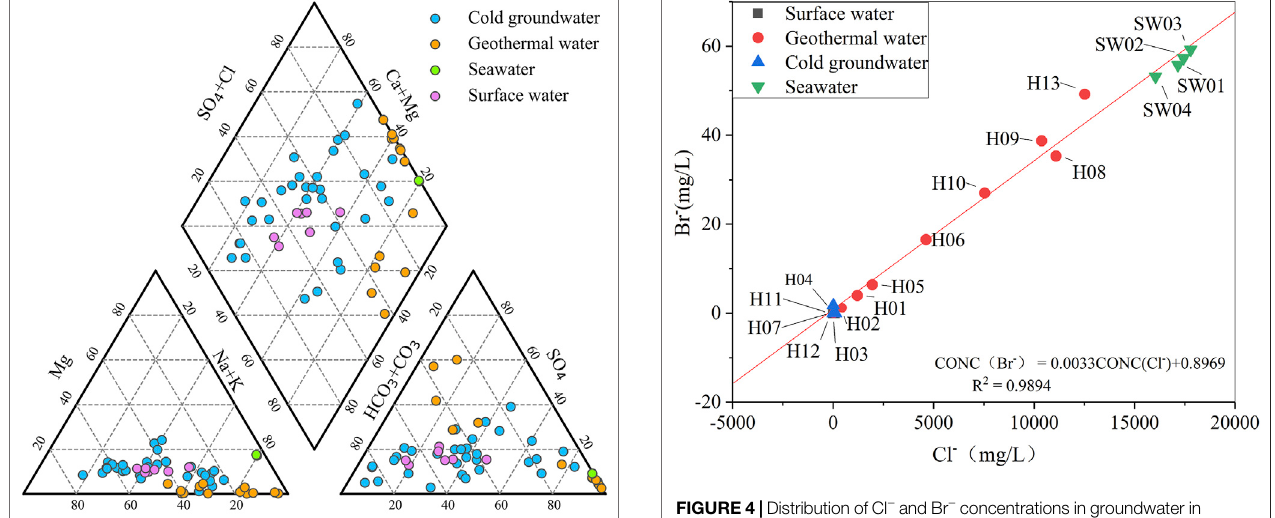
FIGURE 4 | Distribution of Cl − and Br − concentrations in groundwater in